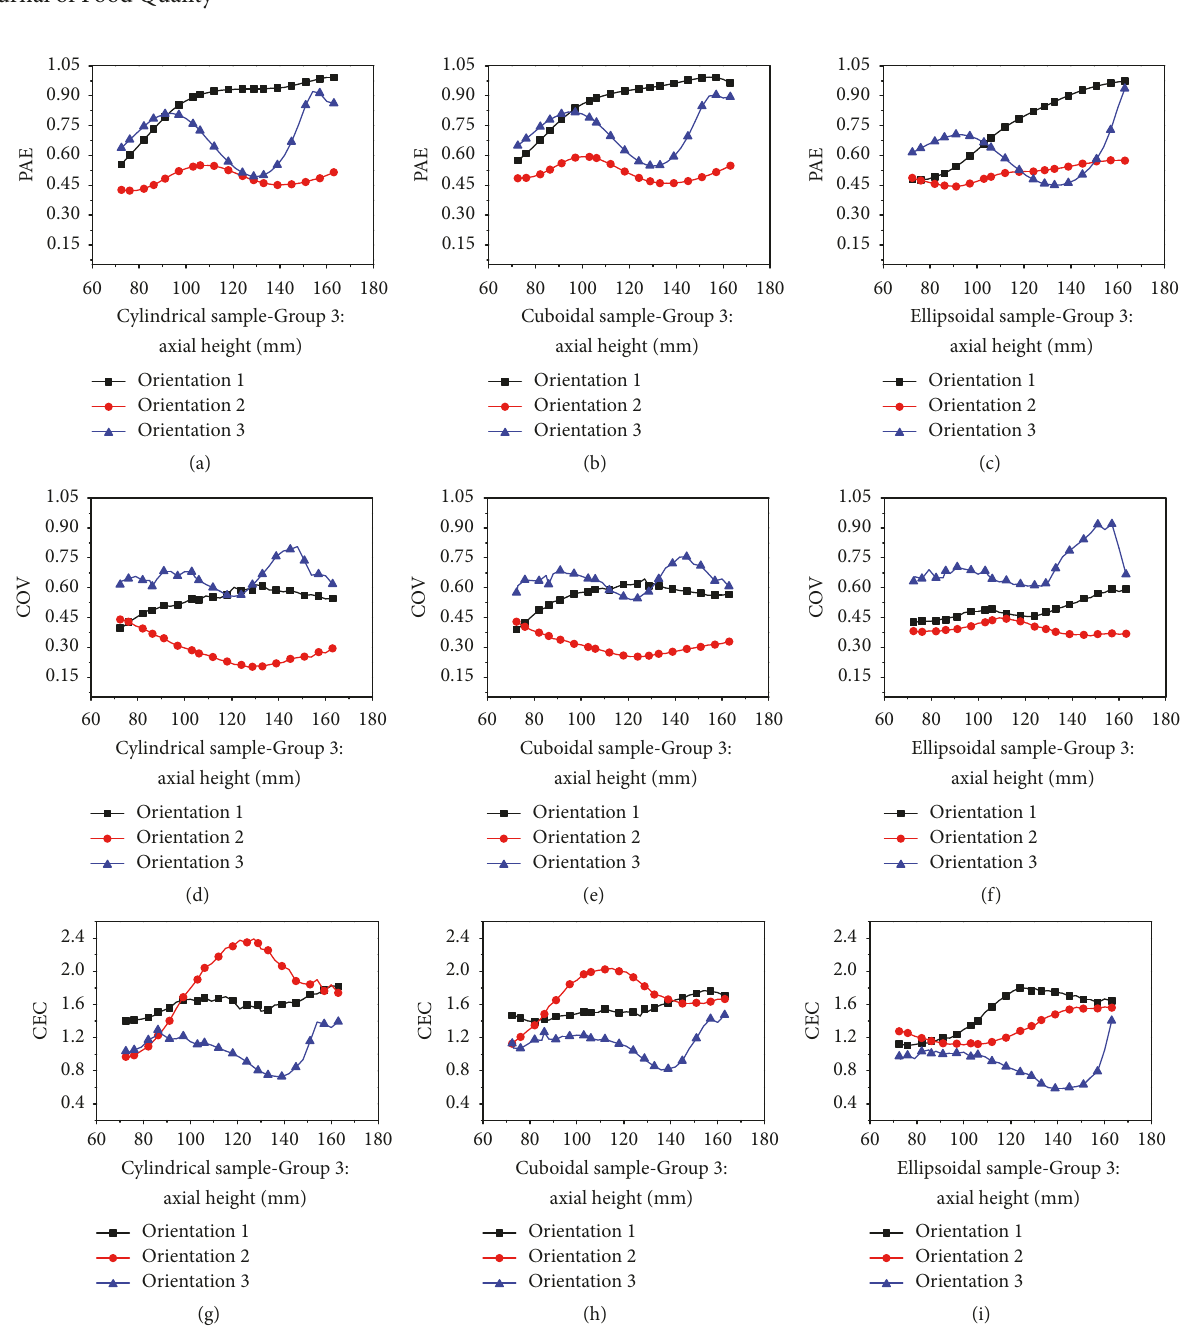
Figure 28: Same samples in different orientations, Group